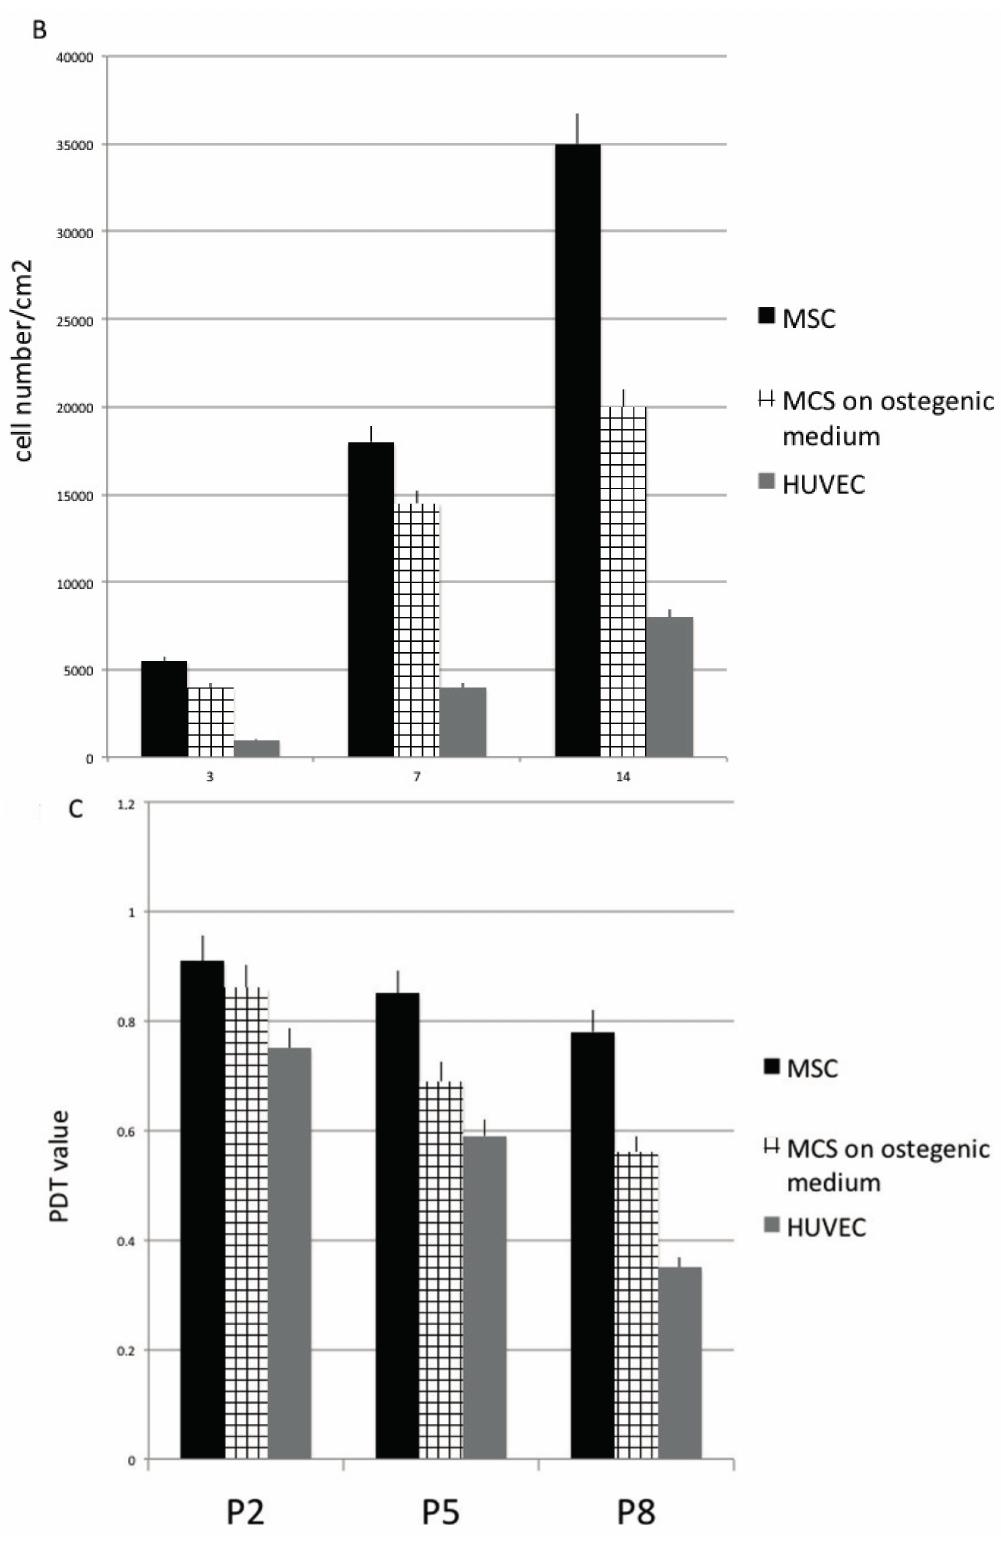
Figure 1. Proliferative activity of Mesenchymal Stem cells (MSC) detected by means of MTT test ( A ), DNA content ( B ) population doubling time (PDT) value ( C ). MSC cultured in presence of nondifferentiative medium: (black bars), osteoinductive medium (squared bars), HUVEC (Human Umbilical Vein Endothelial Cells) (grey